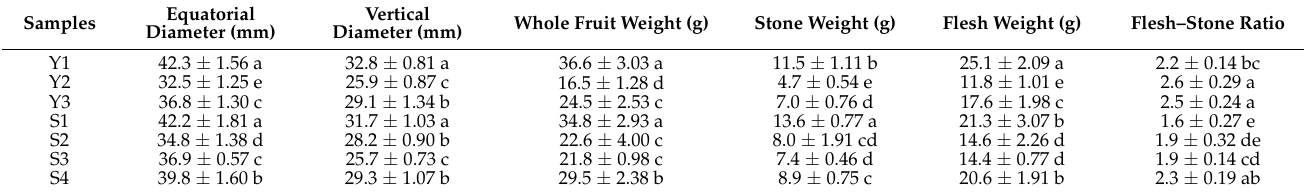
Table 1. Size and weight of the studied